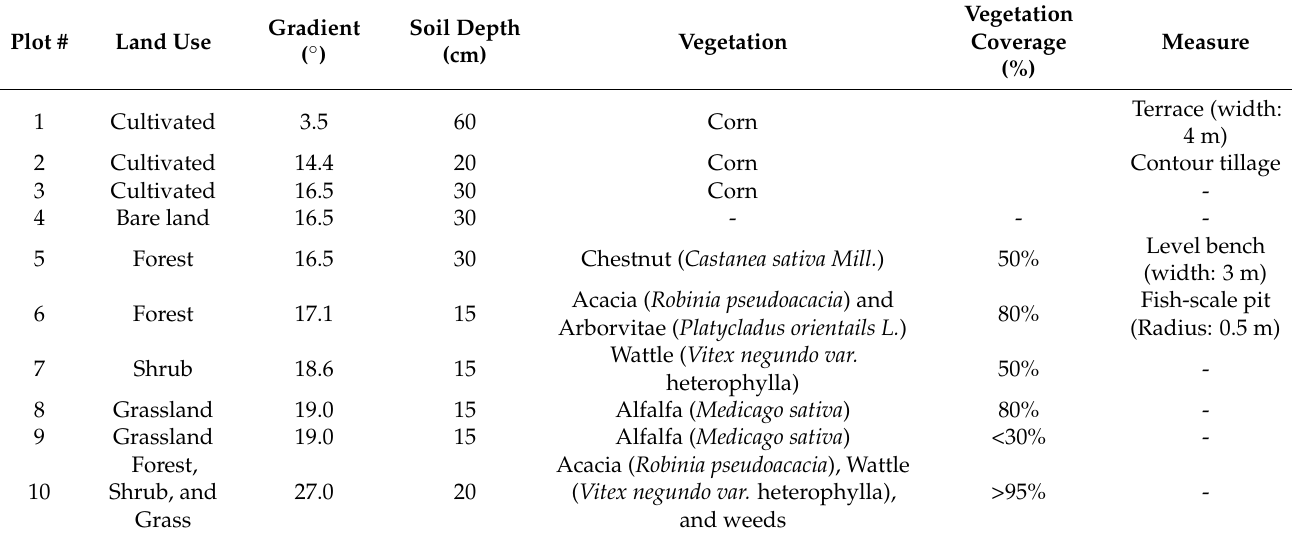
Table 1. Basic characteristics of the 10 runoff plots in the present